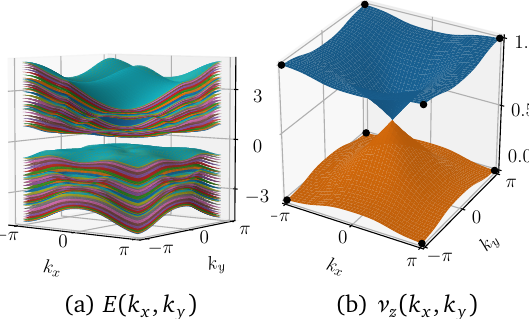
Figure 14: The energy spectrum (a) with open boundary conditions in the z - direction. Wannier spectrum (b) for the Wilson loops in the z -direction. Both graphs are in the topological phase of the system, γ = 0, ∆ = 0.4, µ = 0.5. Size = ( 15 × 15 ) . The gaplessness of the Wannier spectrum is protected by ˜ R spectrum can be gapped without breaking the